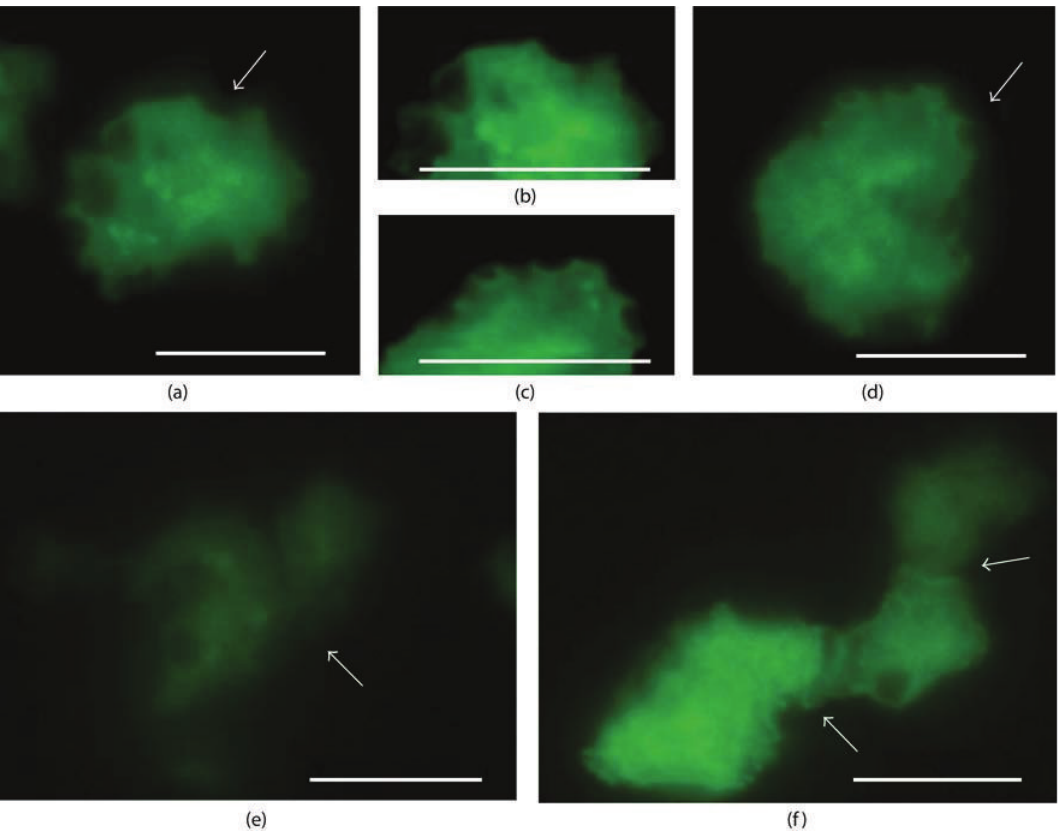
Figure 1: Localization of GFP and GFP/ZYG1 fusion protein. GFP CONT and GFP/ZYG1 OE cells are starved for 2h, fixed with 4% para- formaldehyde for 20 min, and observed under a fluorescence microscope. GFP protein in GFP CONT cells and GFP/ZYG1 fusion protein in GFP/ZYG1 OE cells are shown as the green color of GFP. GFP/ZYG1 fusion protein is preferentially localized at the periphery of vesicles (c, d; arrow) and at the phagocytic cups which are attached to form cell-cell contacts (f; arrows). On the other hand, in GFP CONT cells, GFP protein is uniformly distributed in the cytoplasm (a, b; arrow), and its localization at the region of cell-cell contacts is not observed (e; arrow). This indicates that its localization is due to the presence of ZYG1, but not to GFP itself. Photographs of (b) and (c) are the magnified (a) and (d), respectively, and adjusted to get brighter images. Bars: 20 μ